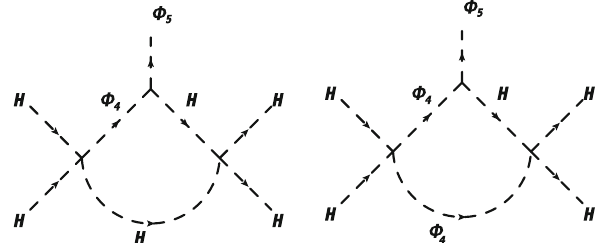
Fig. 1 The one loop diagrams generating dimension 5 term of scalar